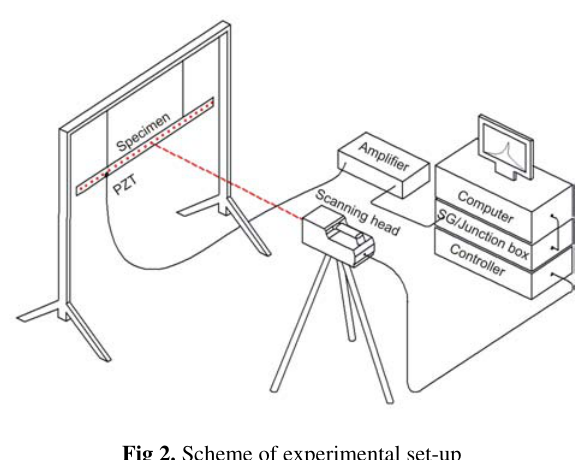
Fig 2. Scheme of experimental